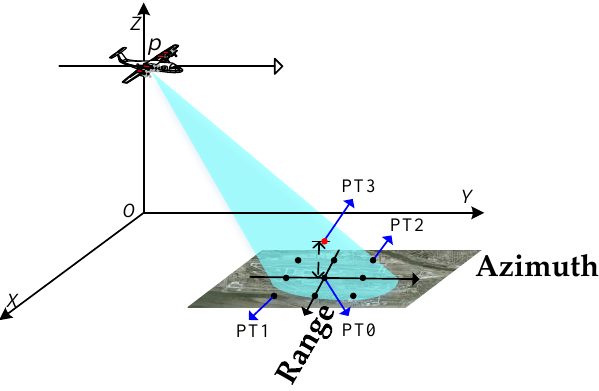
Figure 6. The simulated scene for highly squinted SAR.